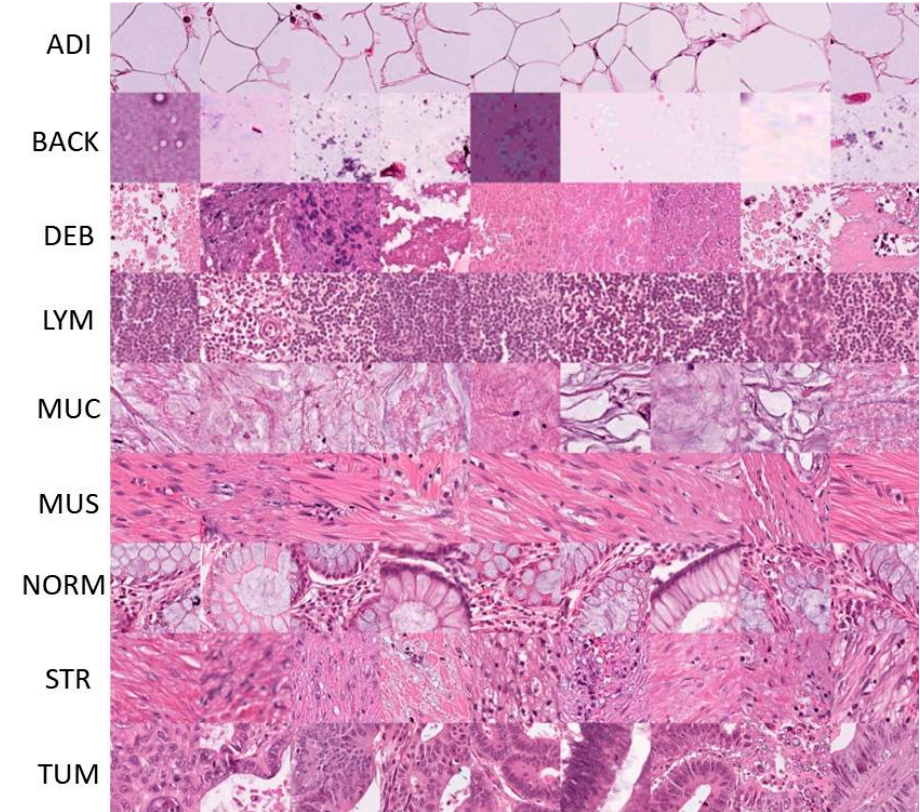
Figure 6. An illustrative image from nine classes of human colorectal cancer datasets.